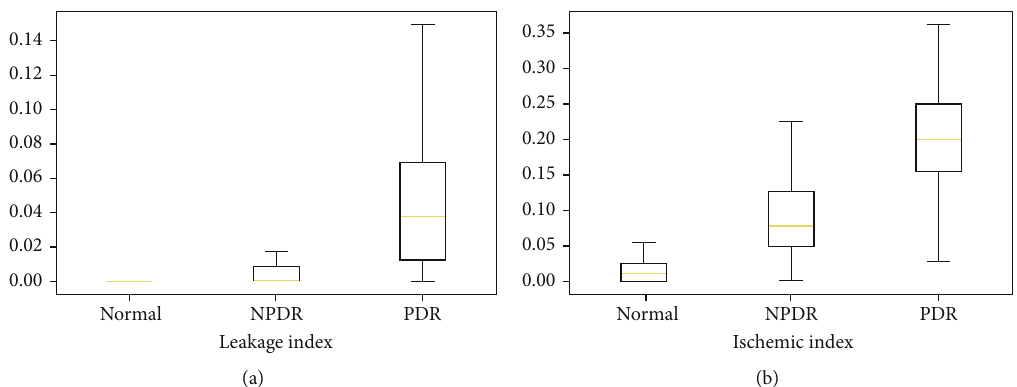
Figure 5: The box-and-whisker plots show that both the ischemic index and leakage index are positively correlated with the severity of DR.